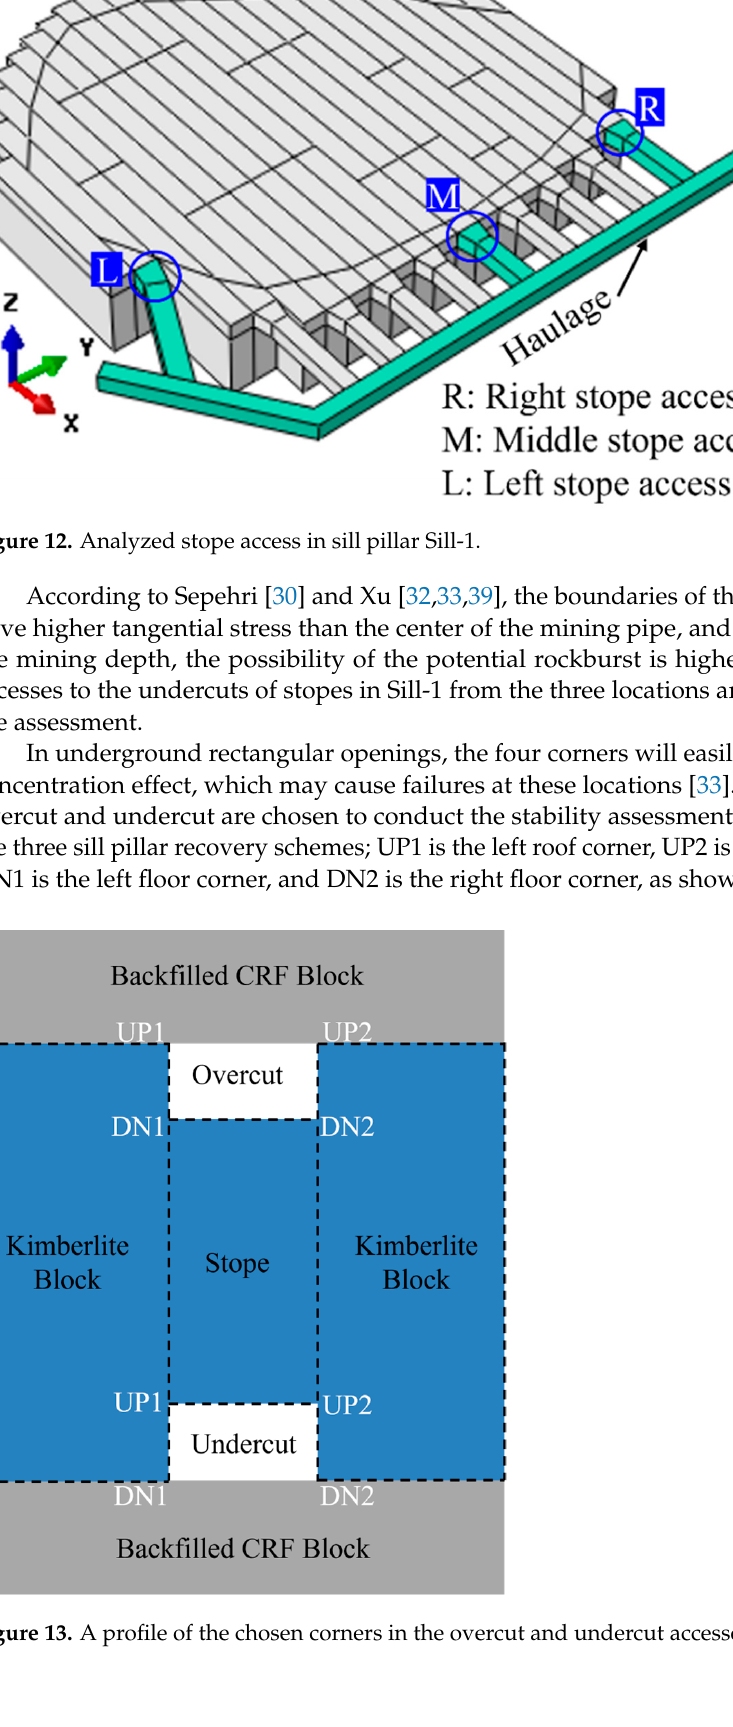
11 of 20 Table 5. Rockburst tendency prediction based on tangential stress criterion. Tangential Stress Criterion (Ts)